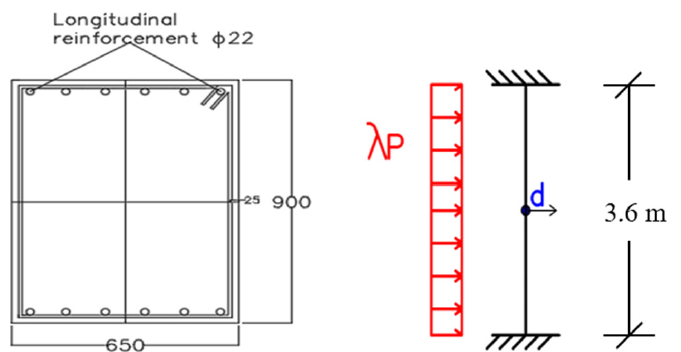
Figure 5. Cross section of the RC column analyzed; structural scheme considered and acting load.